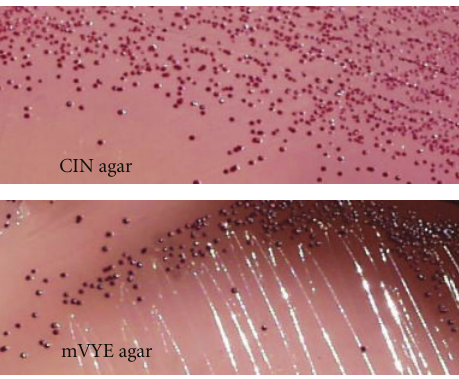
Figure 4: Colonies of Y. pseudotuberculosis grown on CIN agar and mVYE agar incubated at 30 ◦ C for 24 h. Y. pseudotuberculosis forms red pin colonies on CIN agar and dark-red pin colonies on mVYE agar.